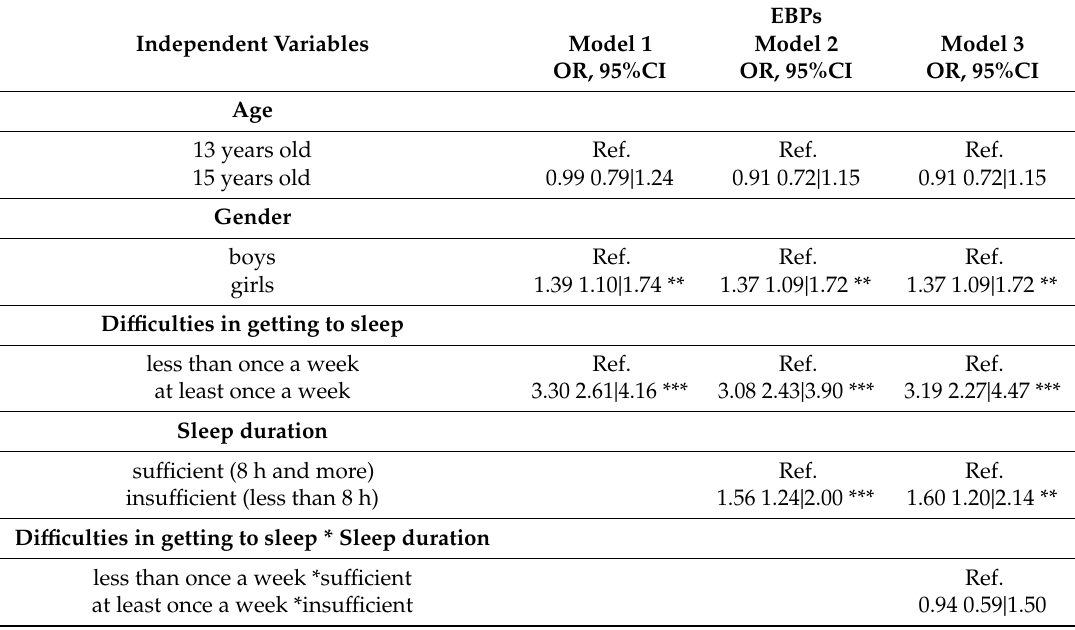
Table 2. The association of di ffi culties getting to sleep with emotional and behavioural problems and the moderation by sleep duration adjusted for age and gender from binary logistic regression